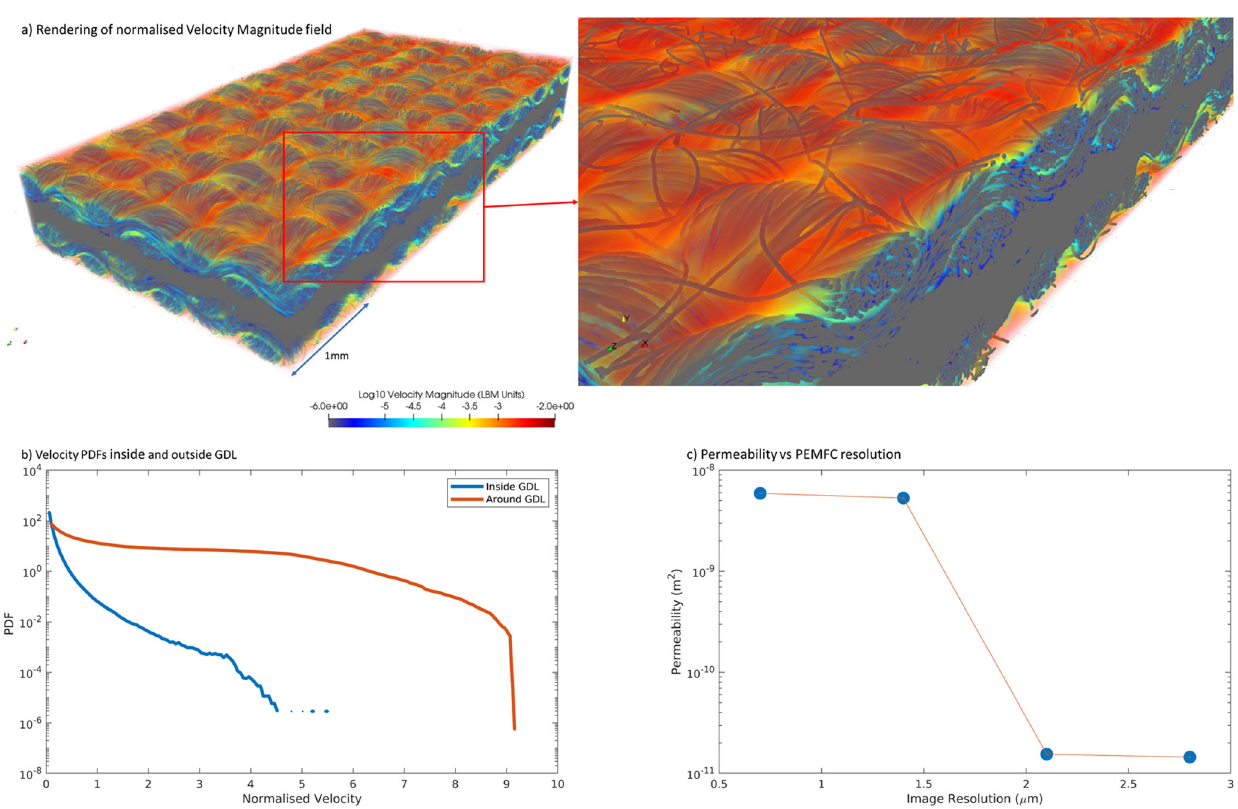
R (cid:1) v dV ∣ of ∣ 1 V V